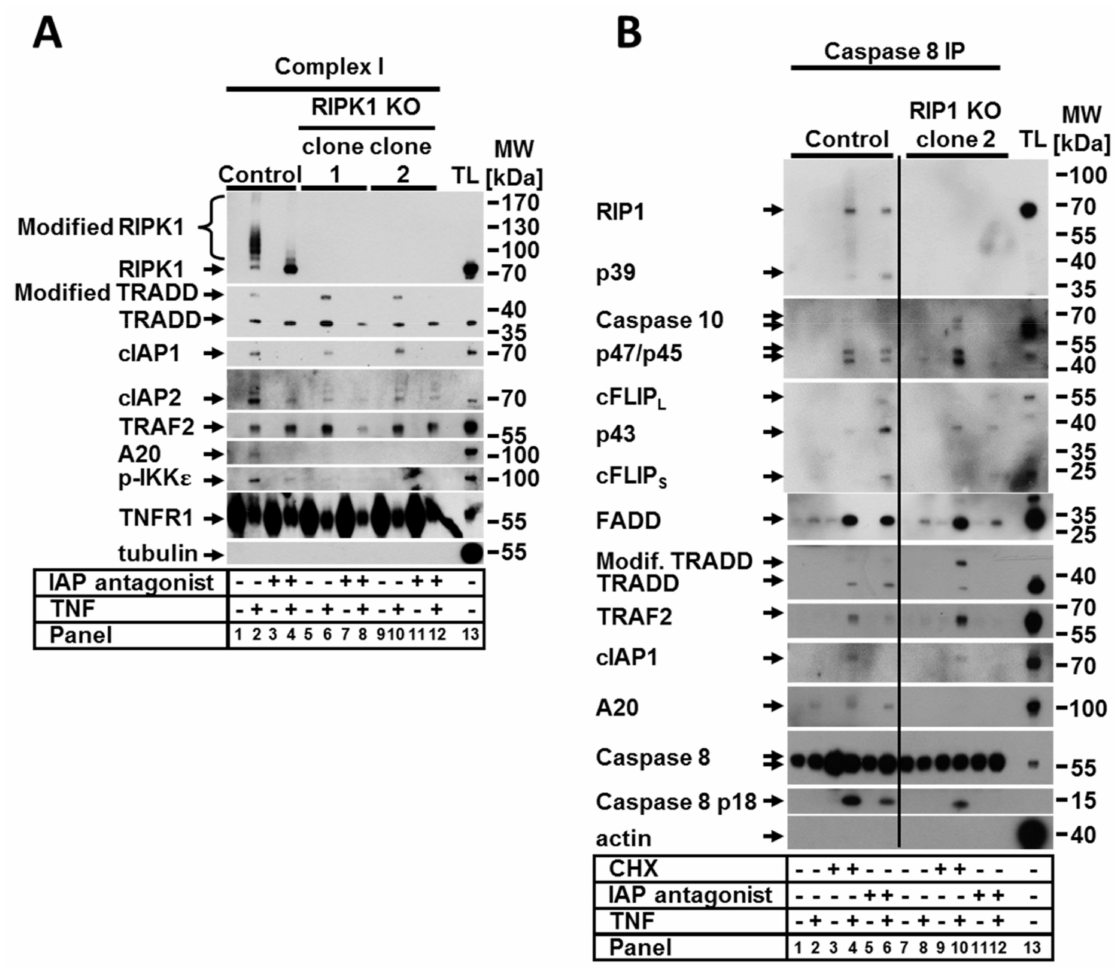
Figure 2. The absence of RIPK1 was not relevant for TNF complex I and IIa formation but was critical for the formation of functional ripoptosome. Control cells and RIPK1 KO clones were stimulated as indicated. ( A ) TNF complex I and ( B ) caspase-8 immunoprecipitation (IP) was performed as described in Section 4. Recruited proteins were analyzed by WB. The WB shown are representative of at least two independent